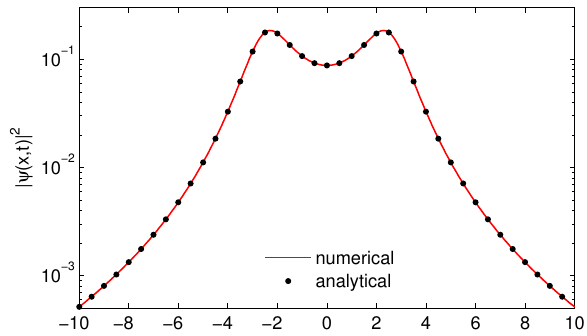
Figure 6. Comparison between the analytical solution Equation ( 31 ) and the matrix approach Equation (62) for the case of a free particle.